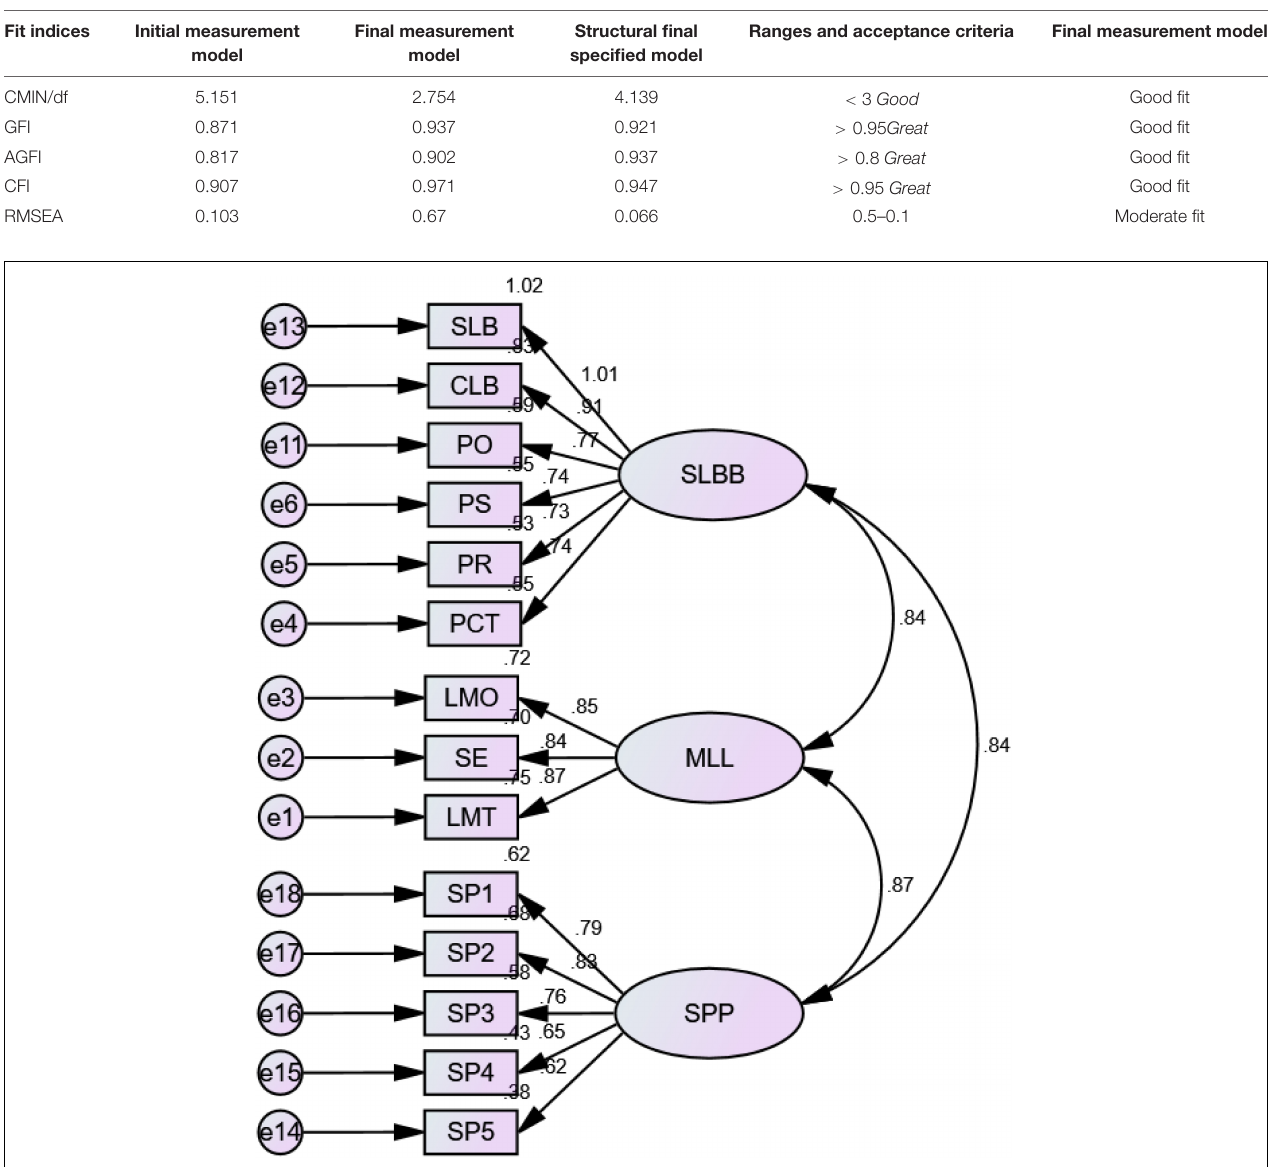
FIGURE 3 | Measurement model